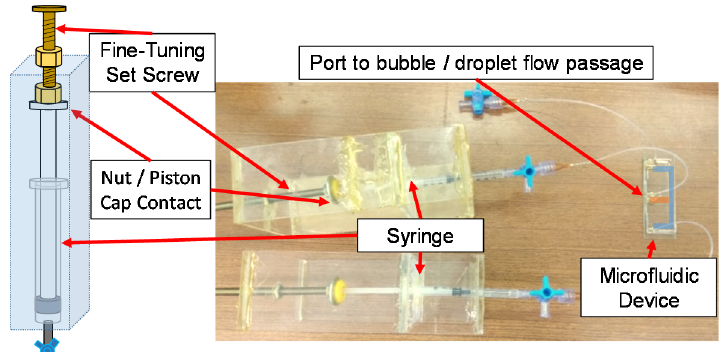
Figure 2. Bubble and droplet control mechanism. The piston cap of the syringe is in contact with the nut sat on the screw. The volume inside the bubble/droplet flow passage can be fine-tuned by controlling the engage/disengage of the nut.